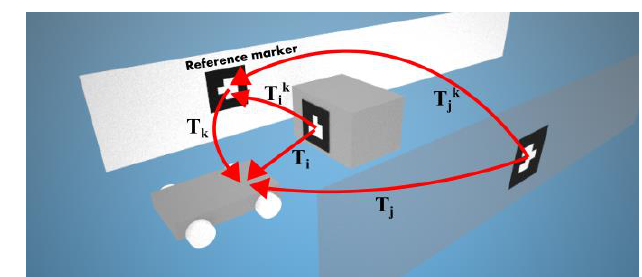
Figure 1. Relationships between markers